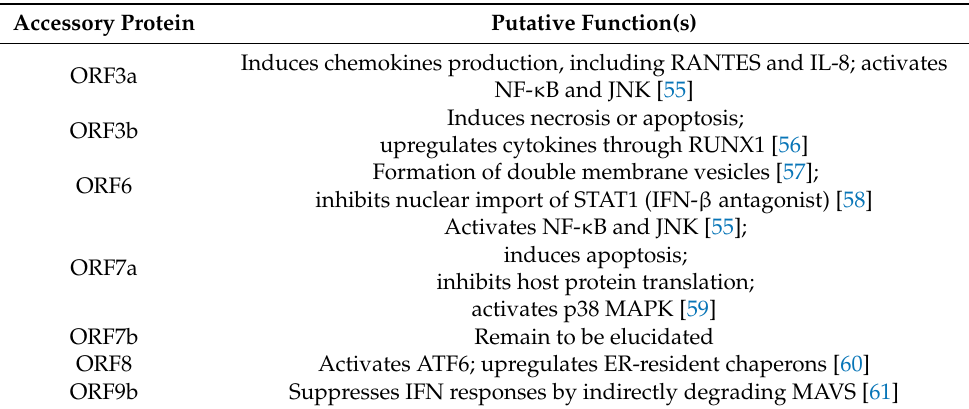
Table 1. Putative functions of SARS-CoV accessory proteins. Accessory